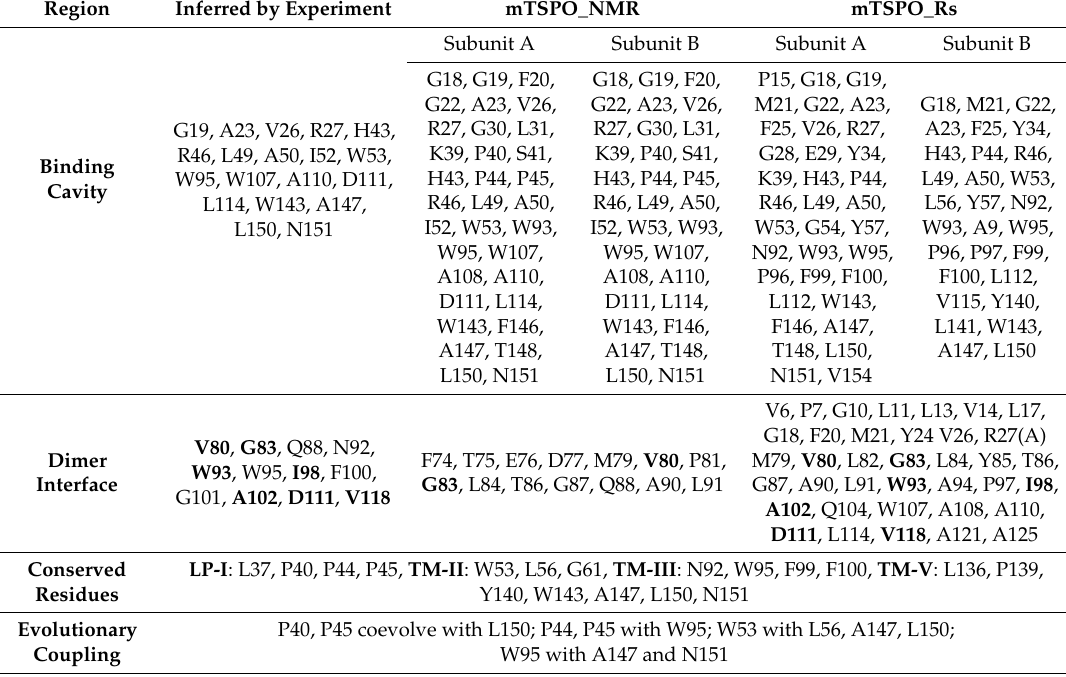
Table 1. Residues of the mTSPO/PK11195 complex located either in the protein binding cavities or at the dimer interface, according to the experimental data [20] and to the proposed dimer models. These models are based either on the NMR structure (mTSPO_NMR, [20] and this work) or on the protein from Rhodobacter Sphaeroides (RsTSPO, this work). Residues at the interface accordingly to both the NMR data [20] and mTSPO_Rs are in bold. mTSPO_Rs’ binding pockets do not include exactly the same residues because of differences of the ligands’ binding poses, as obtained with docking simulations described in the text. On the contrary, mTSPO_NMR binding pockets include by construction exactly the same residues. The residues within 5 Å from the ligand are assigned to the binding cavity and reported in this table. The corresponding list of the residues within 4 Å and 6 Å from the ligand is shown in Table S6 and Figure S5. We report also a list of the residues with a conservation rate higher than 85% in multiple sequence alignment across 148 homologous sequences to the mTSPO, as determined with the ConSurf server [33], along with the topological area of the